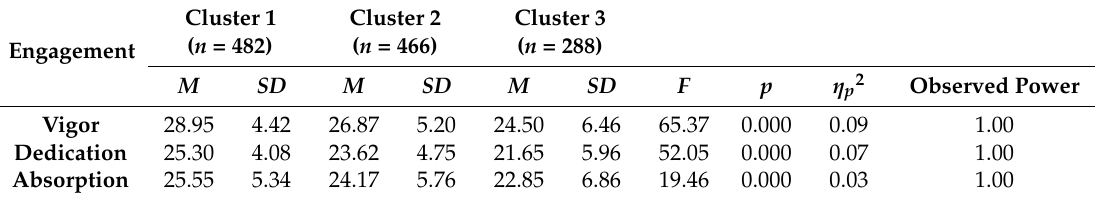
Table 4. Multivariate analysis (between-subject effects by cluster) based on the engagement dimensions.